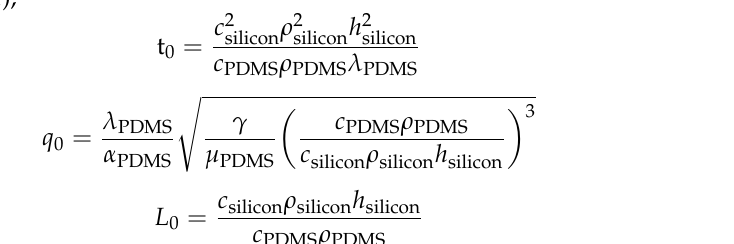
Figure 6. Laser-controlled seal temperature transfer printing technology. ( a ) Laser-controlled seal temperature transfer printing diagram (reproduced from [4]), ( b ) accurate interface fracture mechanics model diagram (reproduced from [59]), and ( c ) the peeling time scale rule of laser-controlled seal temperature transfer printing (reproduced from [59]). In Formula